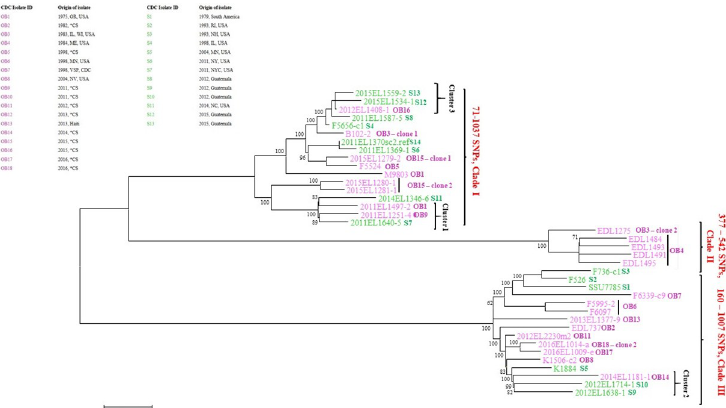
Fig 2. ETEC O6 isolates are clustered into three clades by core genome SNP analysis. Core genome single nucleotide polymorphisms (CG-SNP) tree generated by Parsnp for phylogenetic relatedness of 37 ETEC O6 isolates against the reference genome 2011EL1370-2. The scale represents a distance of 0.02 SNPs per site. Bootstrap percentages are displayed at each ancestor node. Isolates are clustered into Clade I, Clade II and Clade III. Isolates are color coded based on isolation during an outbreak (OB) or sporadic infection (S). In the metadata table, � CS stands for Cruise Ship; US states are abbreviated.